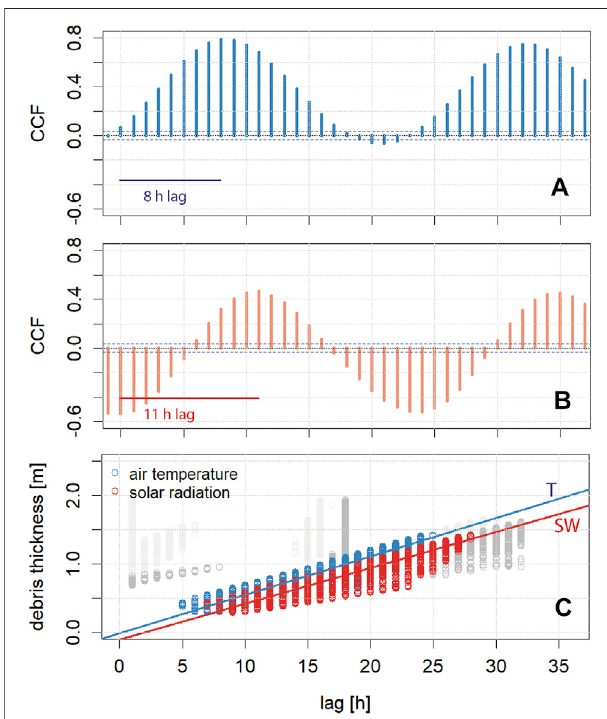
FIGURE 12 | (A) Correlogram showing the cross-correlation function (CCF) between air temperature and melt at a pixel with 51 cm debris thickness. (B) CCF between solar radiation and melt at the same pixel. Horizontal blue lines show the 95% con fi dence interval. (C) Lag derived from the CCF at all pixels against debris thickness. Grey values have no positive correlation and are not considered for the regression.